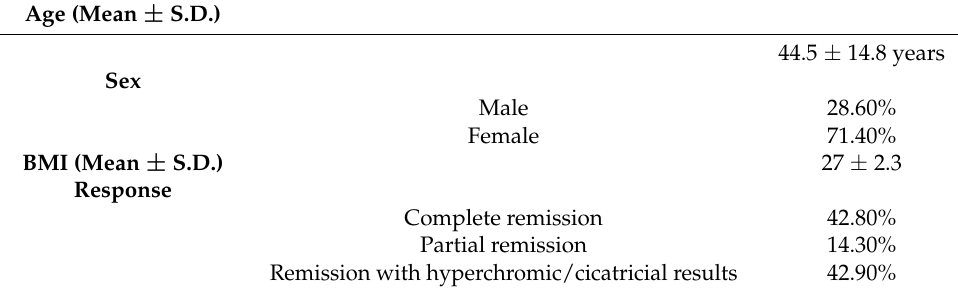
Table 1. DLE patient clinical